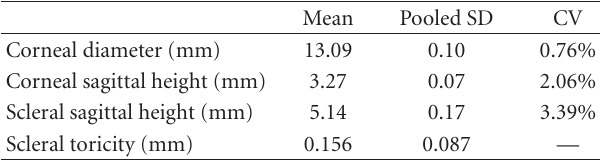
Table 2: Within-subject variance of OCT-measured parameters. Mean Pooled